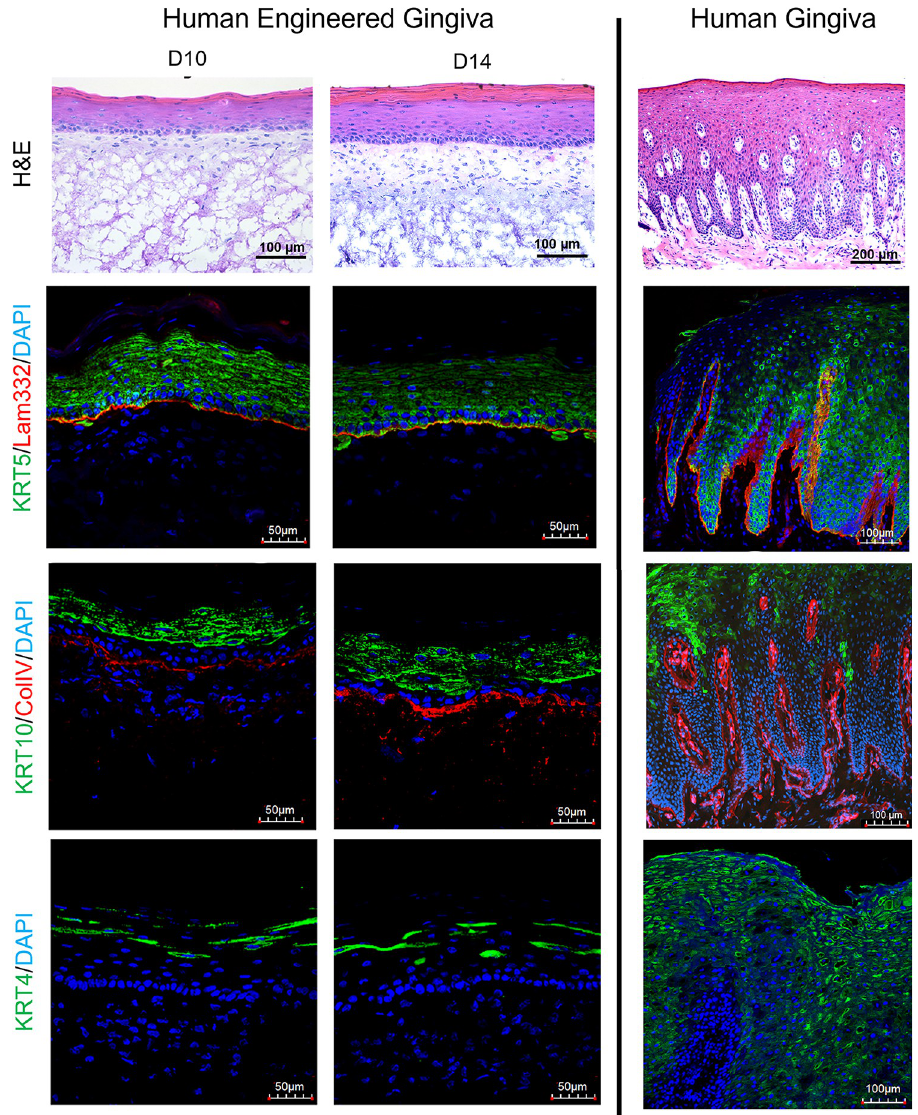
Fig 3. Comparison of cytokeratin and basement membrane protein expression between normal and engineered human engineered gingiva. Immunostained sections of normal human and engineered human gingiva at culture days 10 and 14. Scale bar = 50 μ m for engineered gingiva and 100 μ m for all native human gingiva to capture the entire